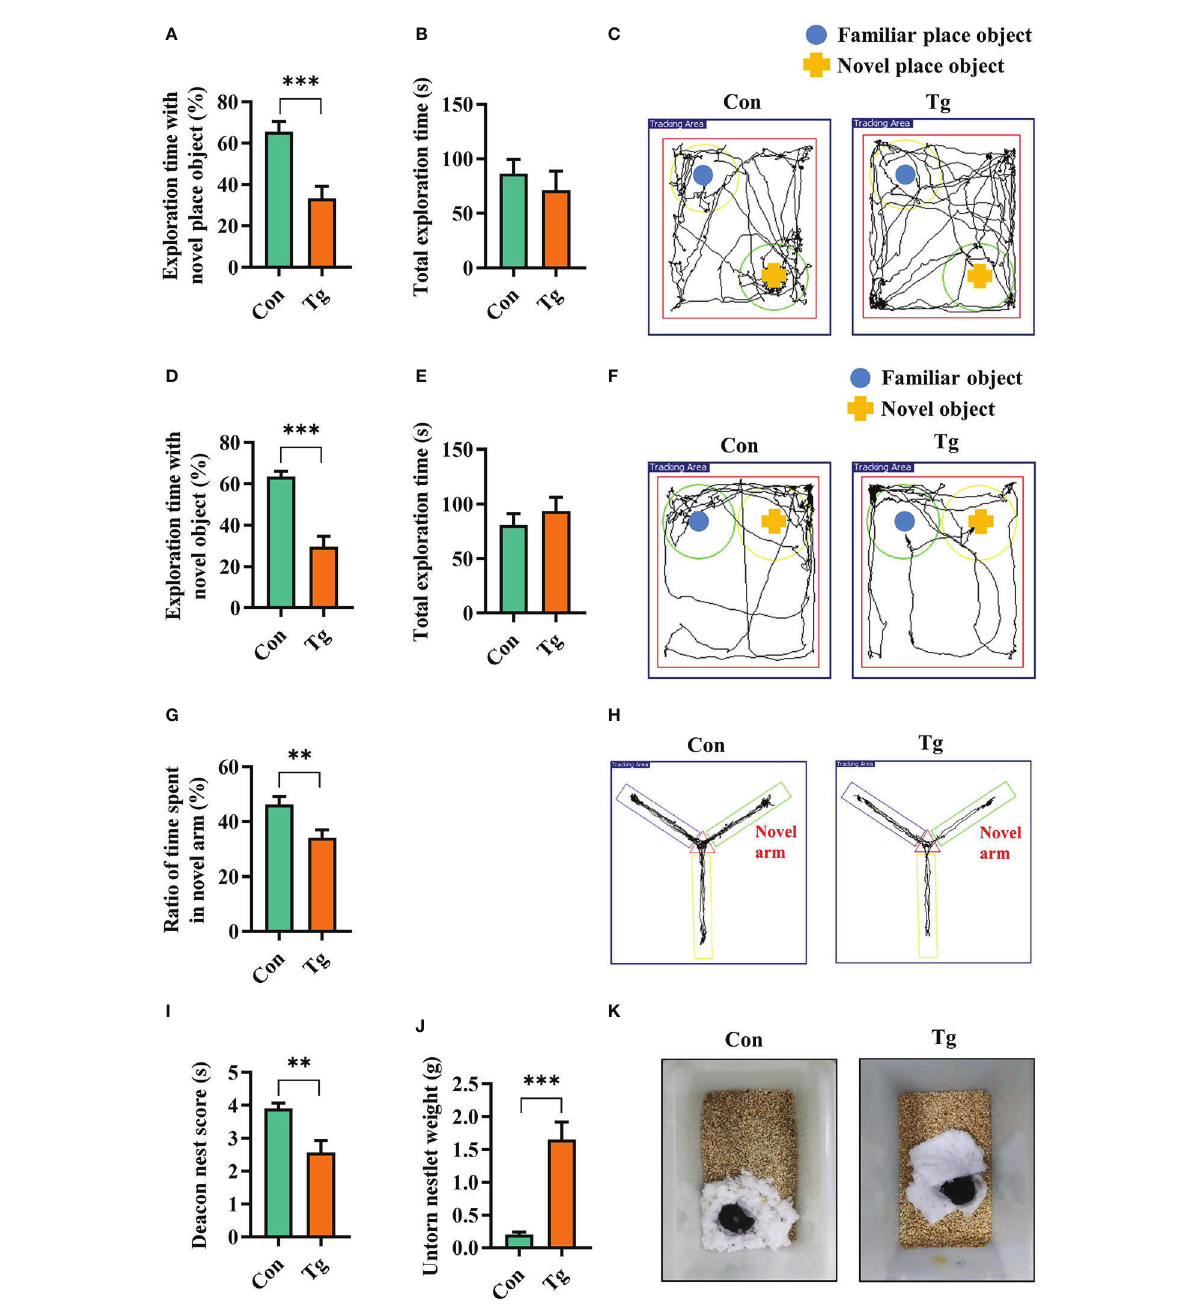
FIGURE 1 T. gondii chronic infection impairs cognitive function in mice. (A) Percentage of time spent with the object in the novel place to total object exploration time and (B) the total object exploration time in the novel location test were recorded. (C) Representative track plots of Con and Tg groups recorded by SMART video tracking system in the testing phase. (D) Percentage of time spent with the novel object to total object exploration time and (E) the total object exploration time in the novel object recognition test were recorded. (F) Representative track plots of Con and Tg groups recorded by SMART video tracking system. (G) Percentage of time spent with the novel arm to total arm exploration time in Y-maze spatial memory test. (H) Representative example of spatial memory in the Y-maze test recorded by SMART video tracking system. Note that the control mouse spent more time exploring the novel arm whereas the mice infected with T. gondii did not show preference to the novel arm. (I) The nest score and (J) untorn nestlet weight (amount of untorn nesting material) ( n = 10 mice for each group). (K) Representative images of nesting result in Con and Tg groups. Con, control mice; Tg, T. gondii infected mice. Values are mean ± SEM. ** P <0.01, *** P